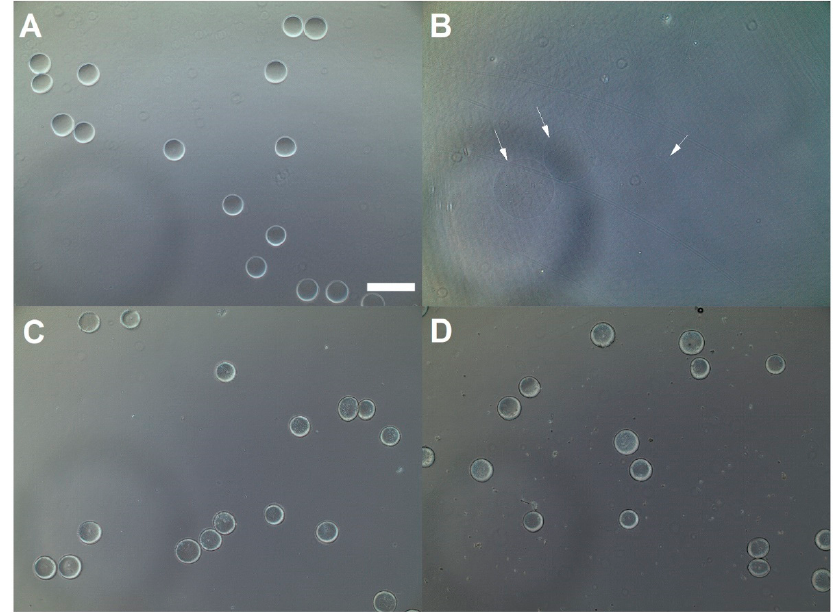
Figure 1. Microscopic images of microspheres: ( A ) PM in DI water; ( B ) PM in PBS; ( C ) EGM (0.75% gelatin) in PBS; ( D ) TGM (0.75% gelatin) in PBS. Arrows indicate highly swollen and disappearing PM. The scale bar represents 500 μ m.